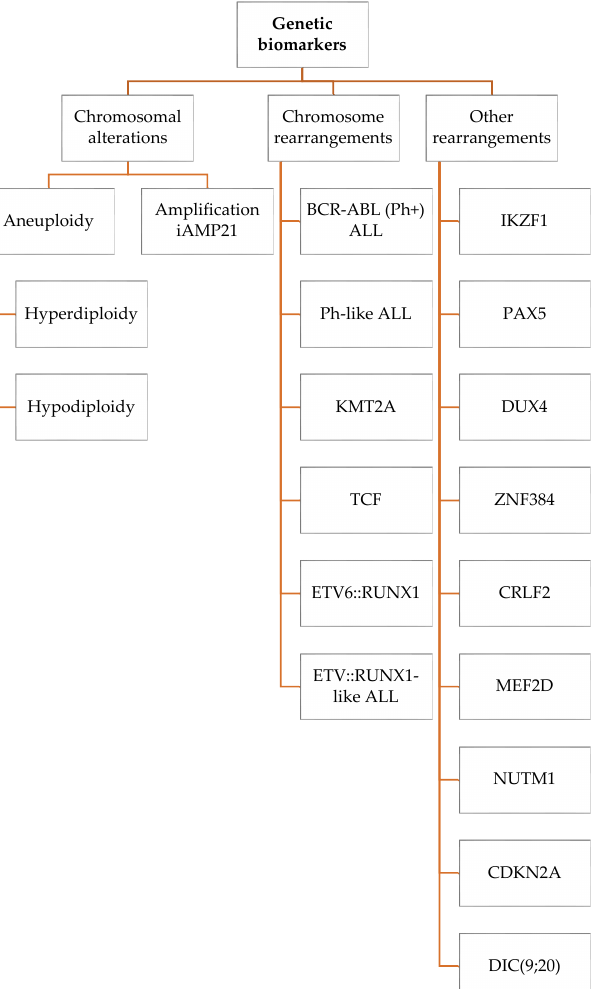
Figure 1. Schematic representation of genetic biomarkers in childhood B-ALL.